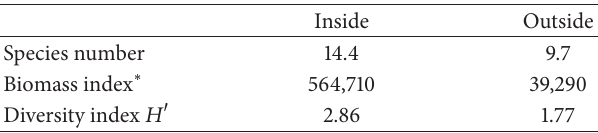
Table 2: Mean values of numbers, biomass indices ∗ , and Shannon- Wiener’s diversity indices 𝐻 󸀠 of plant species appearing in 2 m × 2 m plots inside ( 𝑛 = 5) and outside ( 𝑛 = 5) the deer exclosure at Okutama, western Tokyo, Japan.